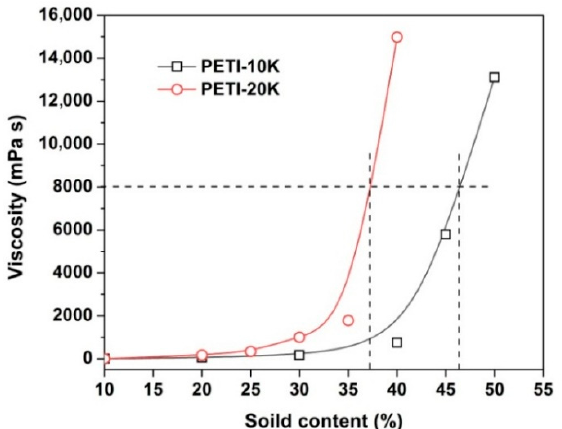
Figure 3. Viscosity ‐ solid contents relationship of PI solutions in DMAc at room temperature. Figure 3. Viscosity-solid contents relationship of PI solutions in DMAc at room temperature.